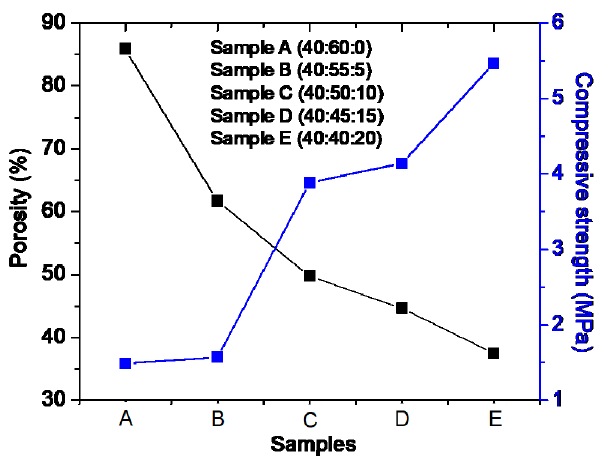
Figure 2. The porosity ( black line ) and compressive strength ( blue line ) of nanocomposite-based scaffold n-HA/Ch/CMC.